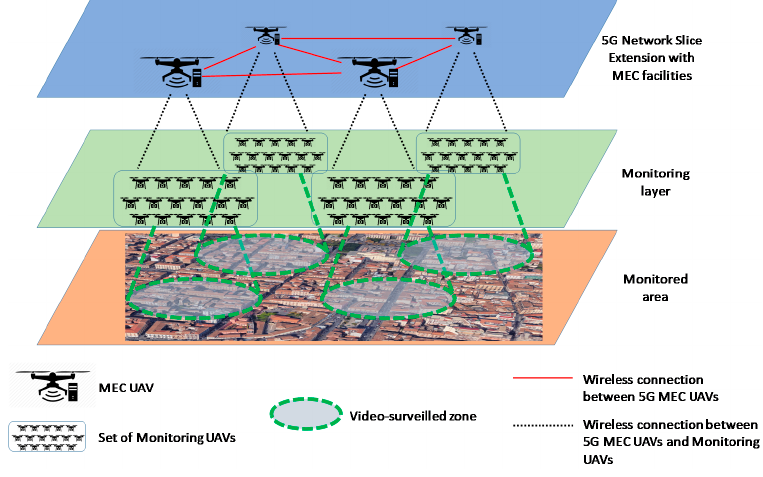
Figure 1. Reference System and Proposed Architecture.